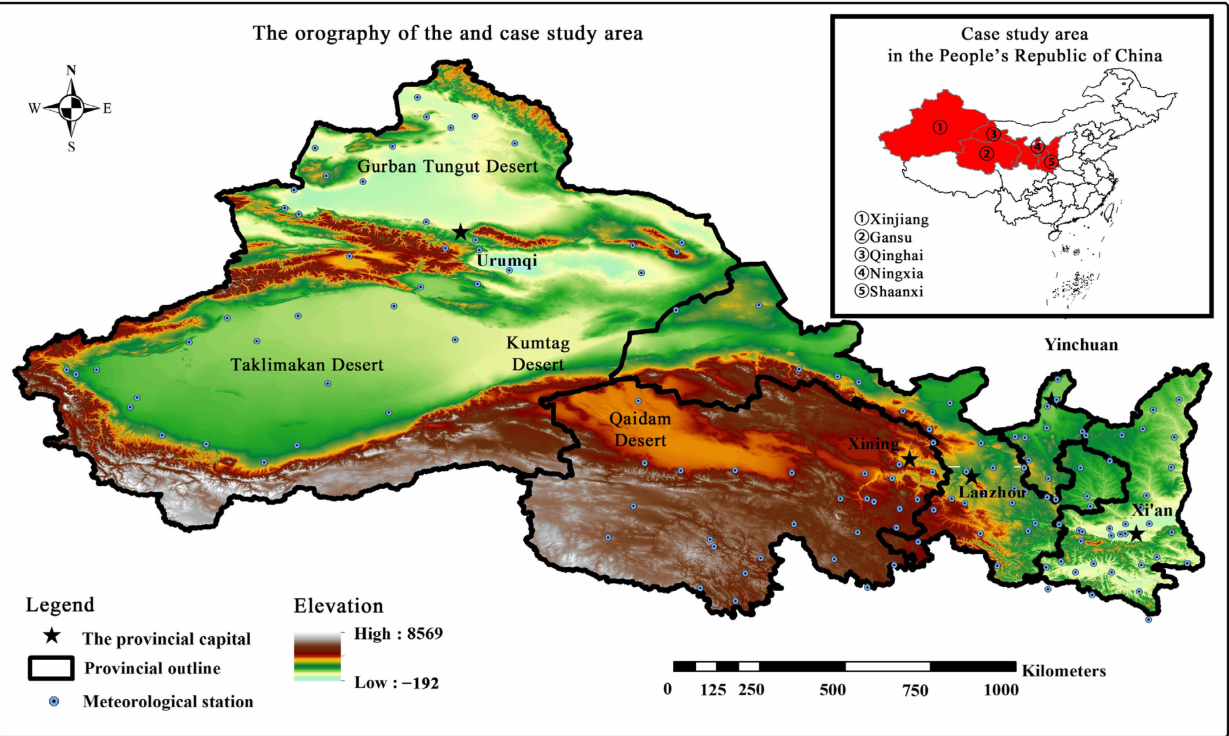
Figure 1. Location of the study